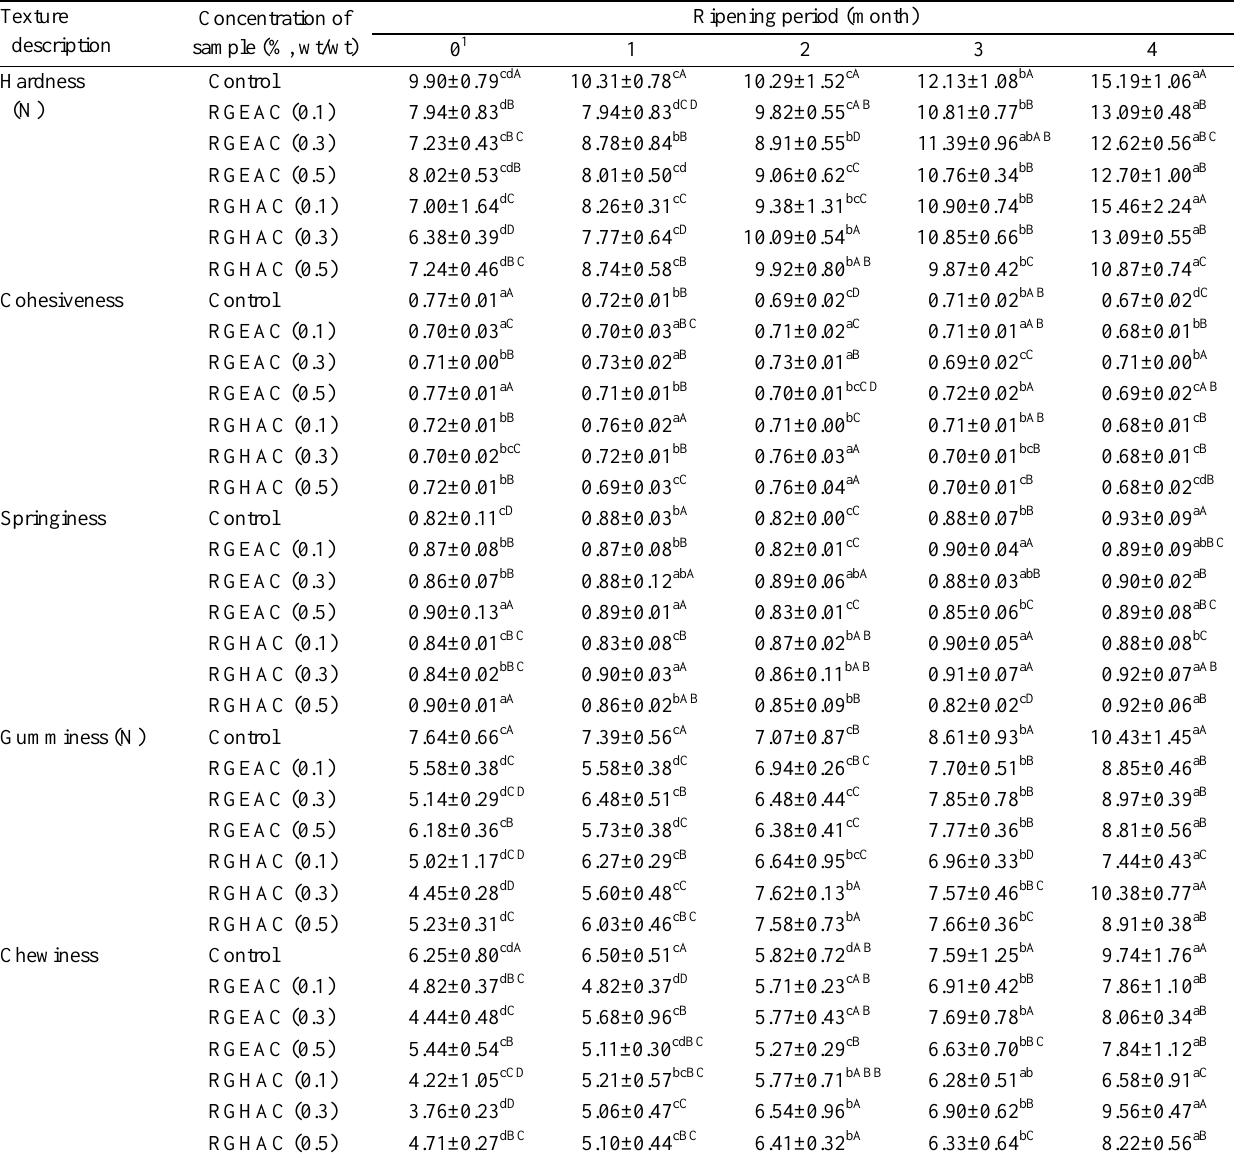
Table 5. Texture properties of red ginseng hydrolyzate- or red ginseng extract-added Asiago cheeses ripened at 14°C for 4 months